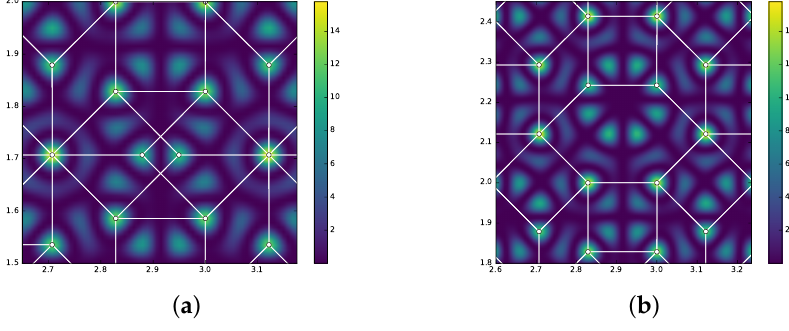
Figure 7. Two close-ups showing the intensity variation in the neighborhood ( a ) of a pair of twin-sites and ( b ) of an empty hexagon of the optical quasicrystal.